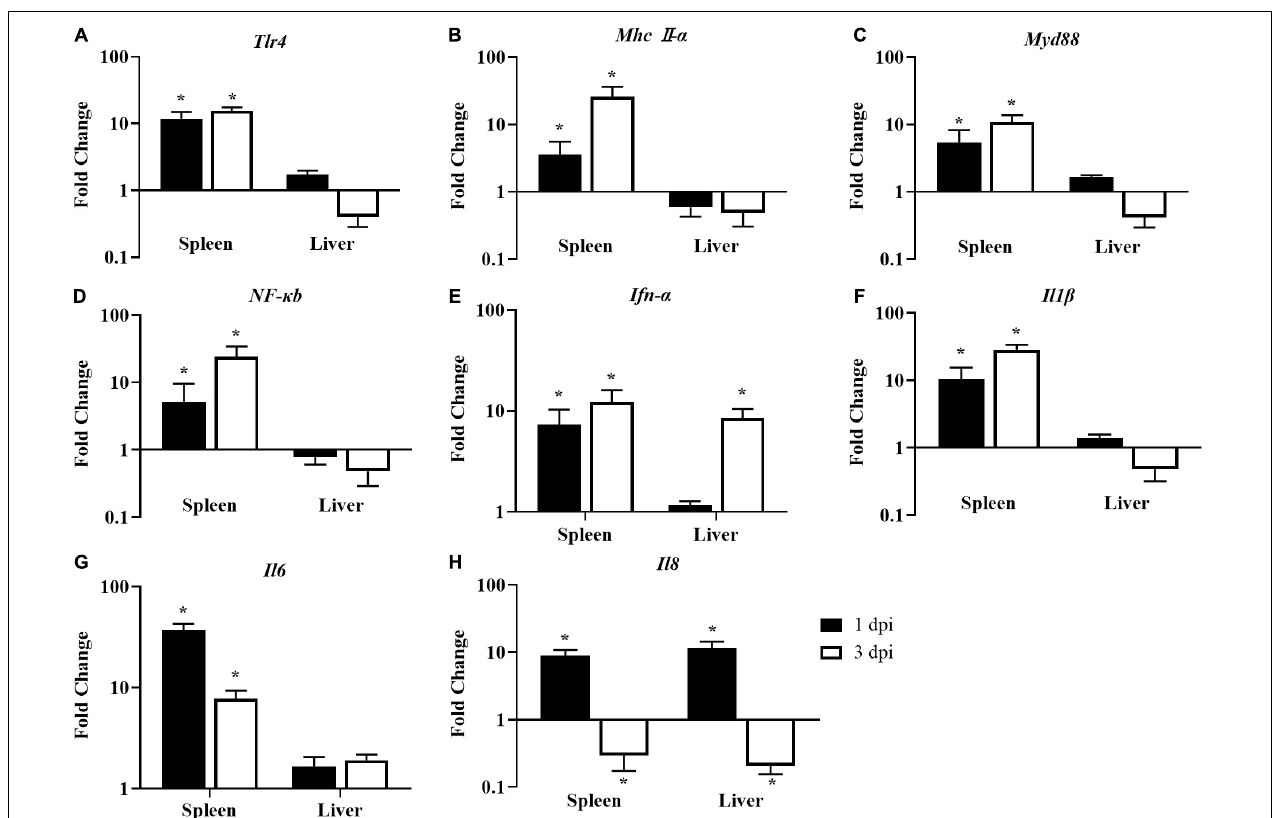
FIGURE 7 | The expression of immune-related genes in the spleens and livers of infected chickens at 1 and 3 dpi. Expression of (A) Tlr4 , (B) Mhc II- α , (C) Myd88 , (D) NF- κ B , (E) Ifn- α , (F) Il1 β , (G) Il6 , and (H) Il8 . The fold change represents the target gene expression in the diet with LGG compared to the diet of the control group. The relative gene expression levels were normalized to β -actin . Bars represent the means ± standard deviations ( n = 5). * p <